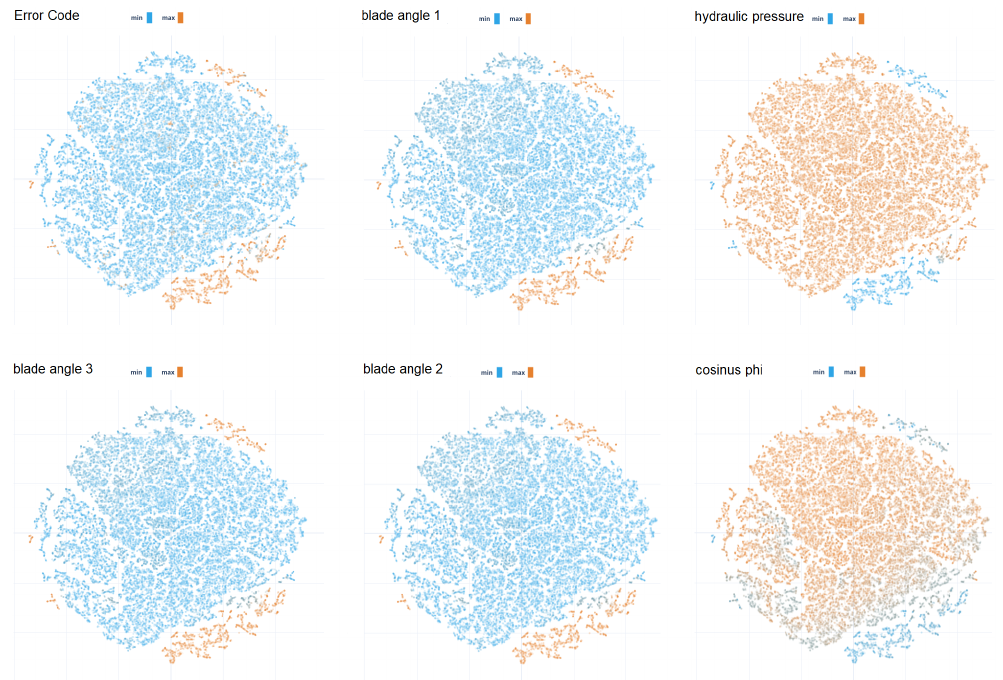
Figure 11. T-SNE projection of error codes and inputs into a 2D space. The error codes cluster well in a few distinct regions and some inputs show high correlation to these clusters. However, all inputs that were identified by this method are consequences of a gearbox failure not a